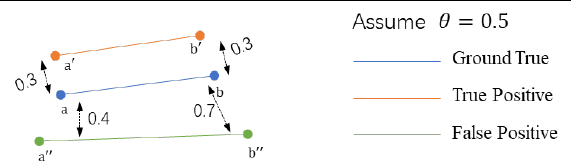
Figure 13. An example of evaluating BIM feature lines. The dots and the lines in the figure represent the vertexes and the lines of the BIM feature. The number is the distance(m) between the line’s